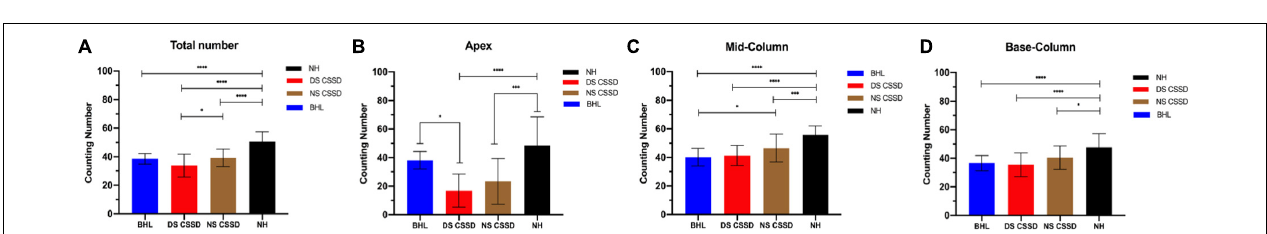
FIGURE 7 | The SEM of saccule and utricle in congenital single-sided deafness (CSSD) pedigree. The deaf side of the CSSD individuals exhibited congenital hair cell malformation with sporadic hair cells left and infused hair bundles. The bilateral hearing loss (BHL) individuals showed the same pathology changes as the deaf side of the CSSD. The microstructure of the utricles in different phenotypes of CSSD pedigree were normal with normal hair cells and otolith.